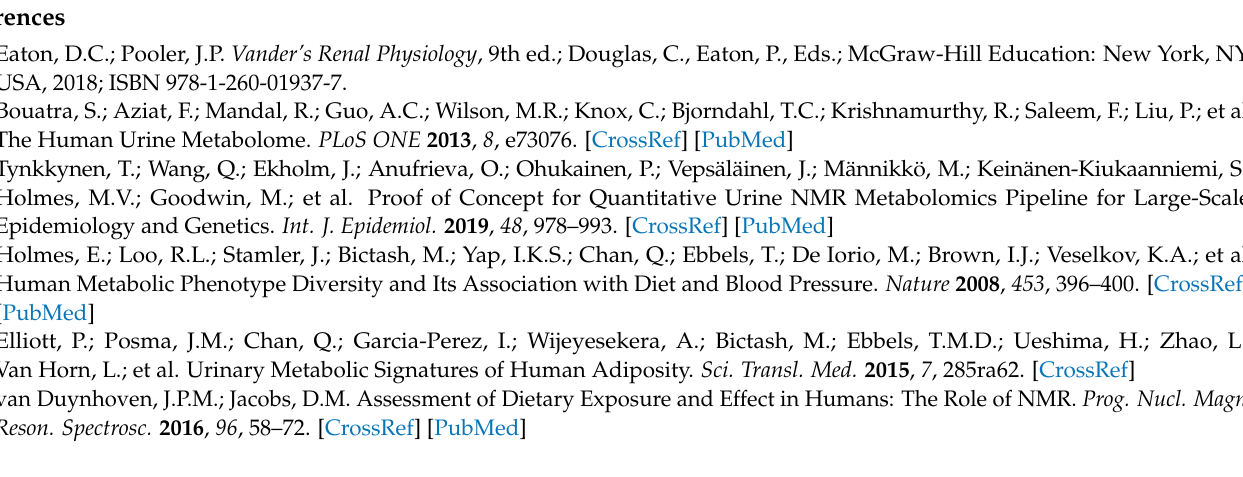
Figure S2: The urinary metabolite–metabolite associations as indicated by Spearman’s rank correla- tions without adjustments for the IS-GLUC and the IS-UREA normalizations. Figure S3: The urinary metabolite–metabolite associations as indicated by Spearman’s rank correlations without adjustments for the IS-PSEURID and the CS normalizations. Figure S4: The urinary metabolite–metabolite as- sociations as indicated by Spearman’s rank correlations without adjustments for the PQN and the DESeq2 normalizations. Figure S5: The associations of the urinary metabolite concentrations with BMI (without adjustment) for the various normalization schemes. Figure S6: The associations of the urinary metabolite concentrations with BMI (adjusted for sex) for the various normalization schemes. Figure S7: The associations of the urinary metabolite concentrations with MAP (without adjustment) for the various normalization schemes. Figure S8: The associations of the urinary metabolite concen- trations with MAP (adjusted for sex) for the various normalization schemes. Figure S9: Comparison of the epidemiological associations of the urinary metabolite concentrations via IS-CREA and PQN normalization with